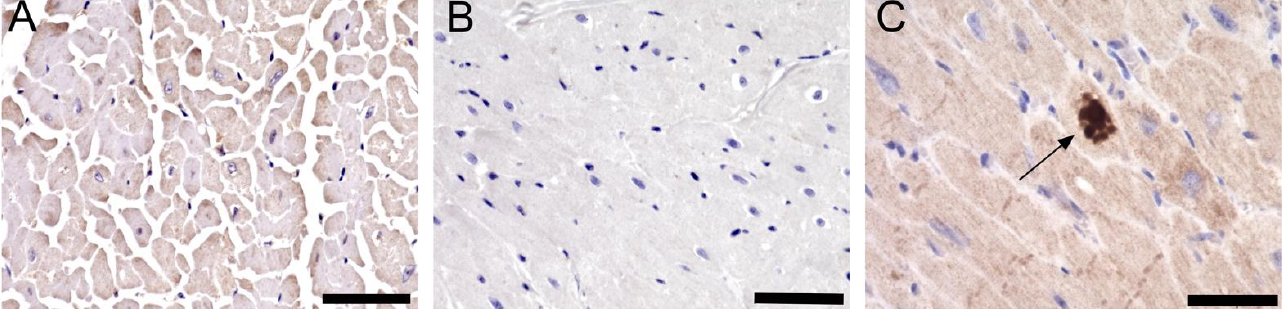
Figure 4. SARS-CoV-2 is localized in the myocardium of infected monkeys. Representative images shows IHC staining done on ( A ) control cardiac tissue with the SARS-CoV-2 N protein antibody, ( B ) myocardium of SARS-CoV-2 infected cardiac tissue with IgG control antibody, and ( C ) SARS-CoV-2 infected cardiac tissue with the N protein antibody. Arrow shows positive staining (dark brown). Scale bar and magnification: 50 µm at ×400.